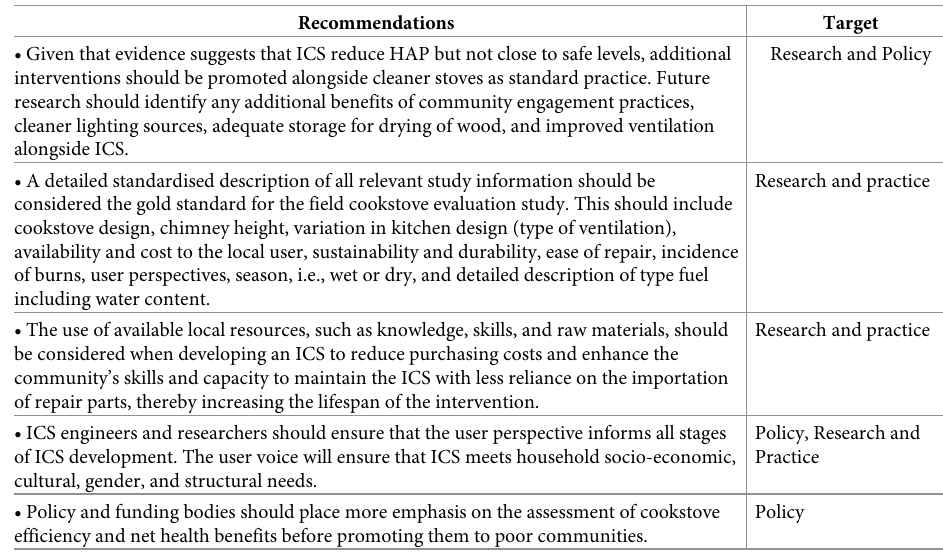
Table 7. Recommendation for research, practice, and